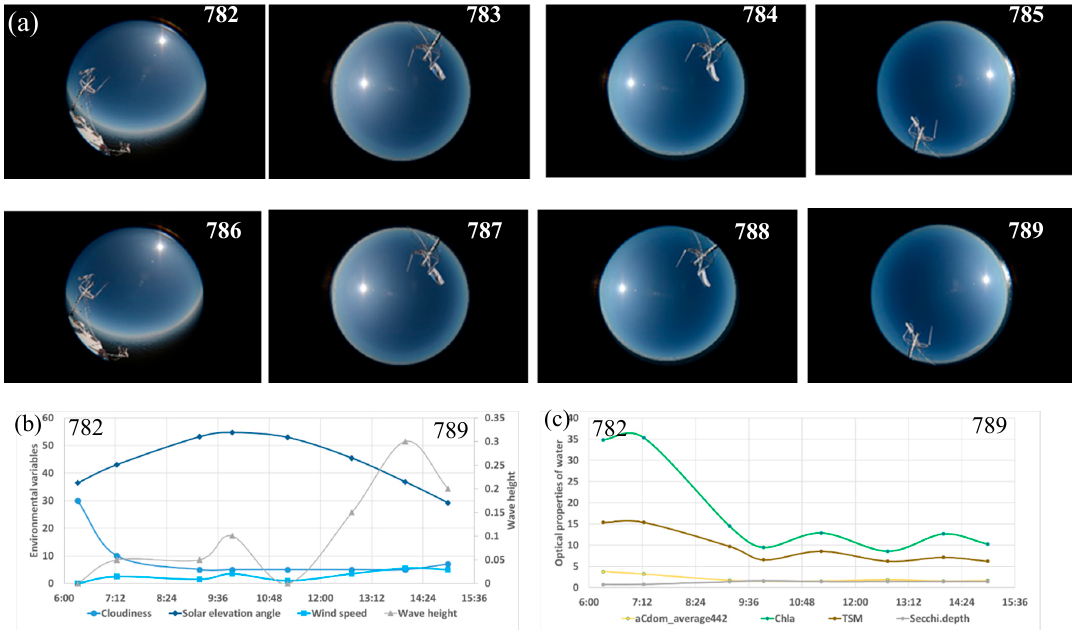
Figure A1. The changes in the sky conditions ( a ), the temporal and spatial changes in the measurement conditions ( b ) and optical properties of water ( c ) on 14th June 2016.